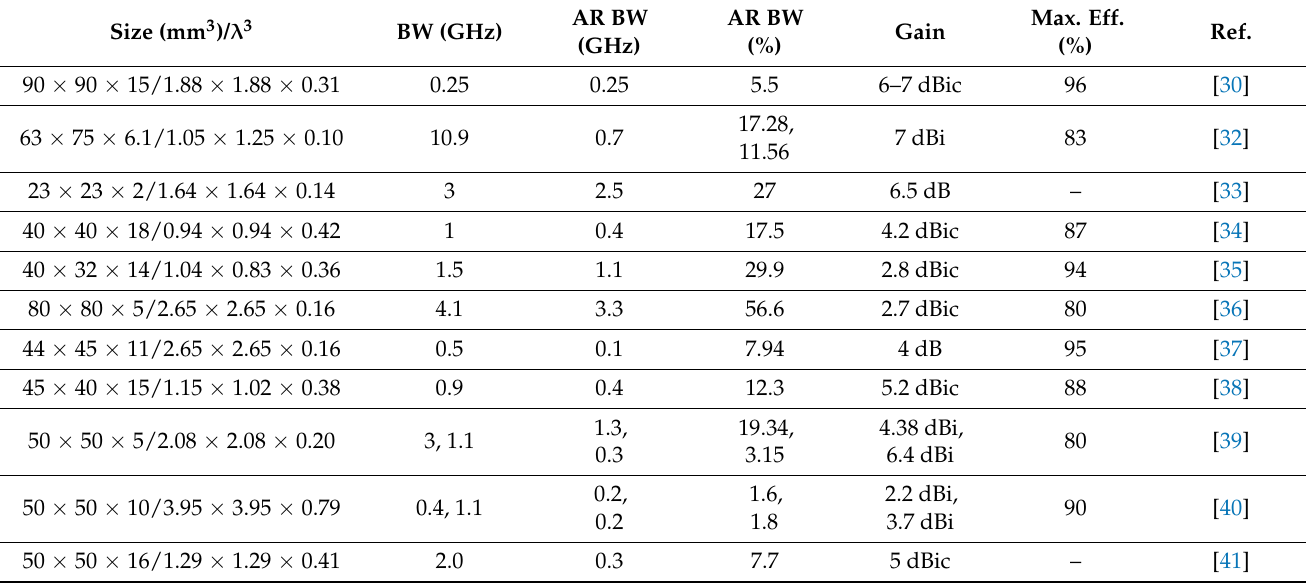
Table 2. Comparison of the proposed design with the state-of-the-art published